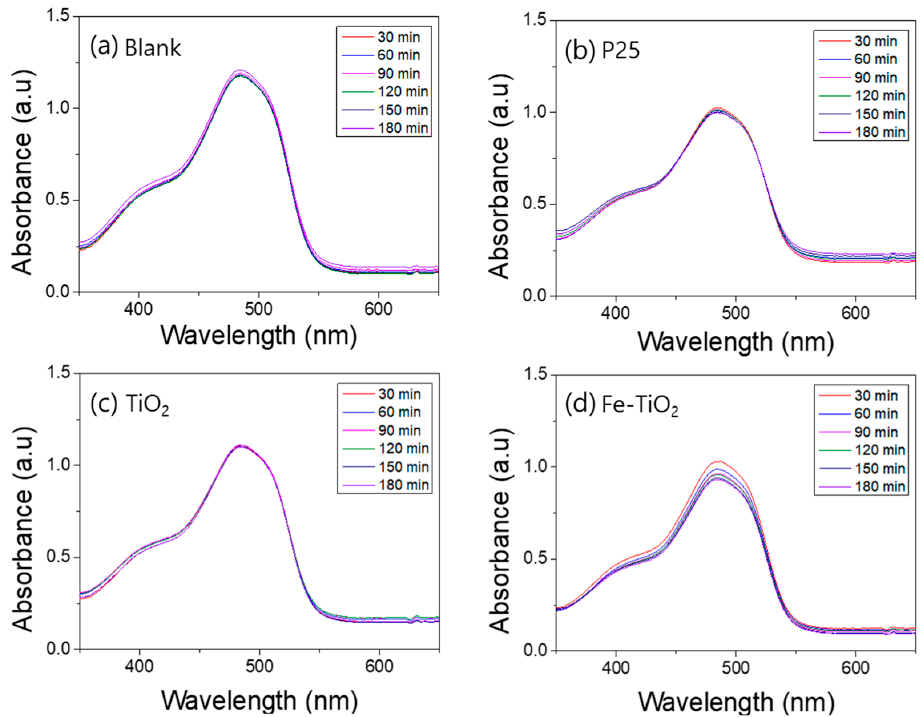
Figure 10. UV–Vis absorption spectra of the visible light photocatalytic degradation of an aqueous methylene blue solution by nanofibers: ( a ) blank, ( b ) P25, ( c ) TiO 2 nanofibers, ( d ) Fe-doped TiO 2 nanofibers.